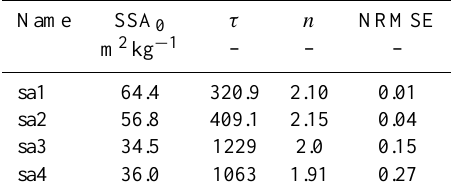
Table 3. Values of the fitted growth rate τ and growth exponent n for the evolution of the SSA including the sintering time of 13 and 27 days, and the corresponding normalized root mean square error (NRMSE).